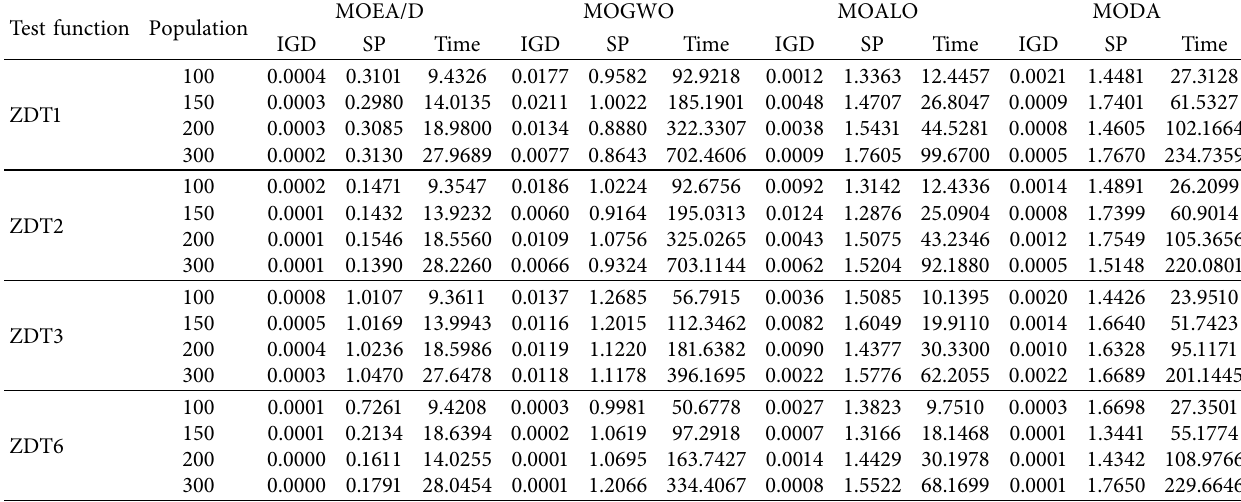
Table 13: Assessment results of MOEA/D and compared algorithms MOGWO, MOALO, and